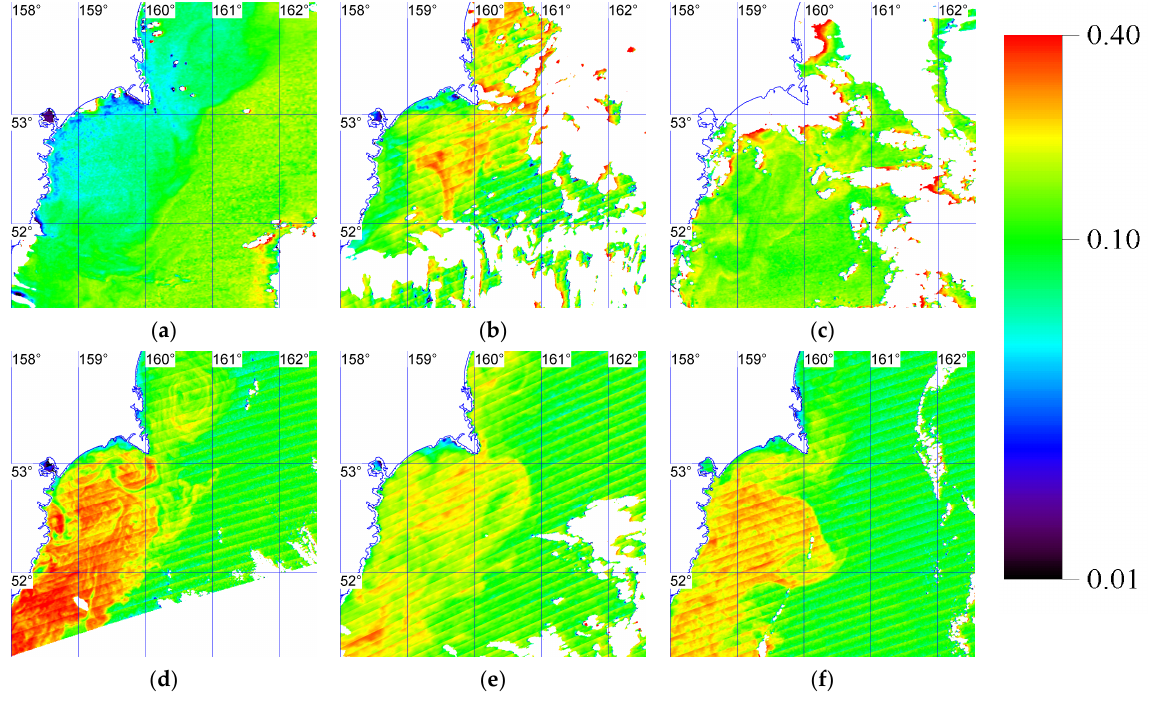
Figure 3. Specific fluorescence (mW cm −2 µm −1 sr −1 mg −1 ∙m 3 ) in the Avacha Gulf for the following dates: ( a ) September 9, ( b ) September 21, ( c ) September 25, ( d ) October 3, ( e ) October 9, ( f ) October 12. MODIS/AQUA.